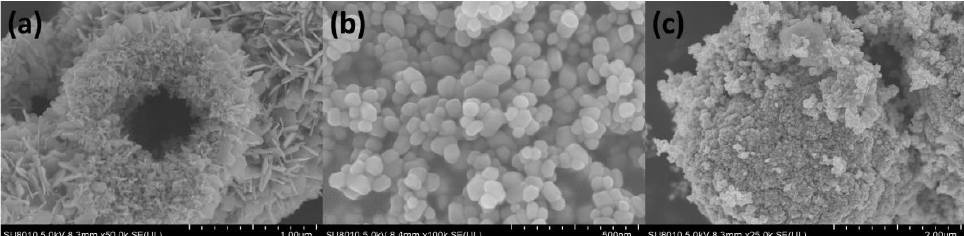
Figure 3. SEM images of BMO ( a ), ZnO ( b ), and BZO ( c ). The microstructure of ZnO, BMO and BZO were analysed by transmission electron microscopy (TEM), as shown in Figure 4. It could be found that a large number of ZnO nanoparticles were wadded on the surface of the BMO nanospheres (Figure 4a,b), which also confirmed the successful preparation of BZO. The morphologies of BMO microspheres and BZO heterojunctions were similar. As a result, the formation of heterojunctions does not destroy the original morphology of BMO microspheres.